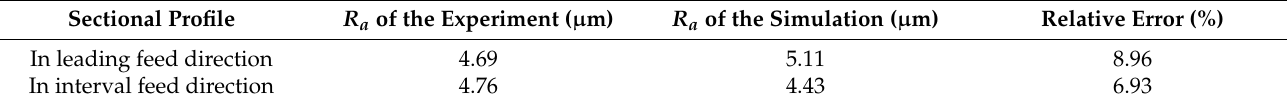
Table 4. R a of the experimental and simulated sectional profiles obtained by vertical milling. Sectional